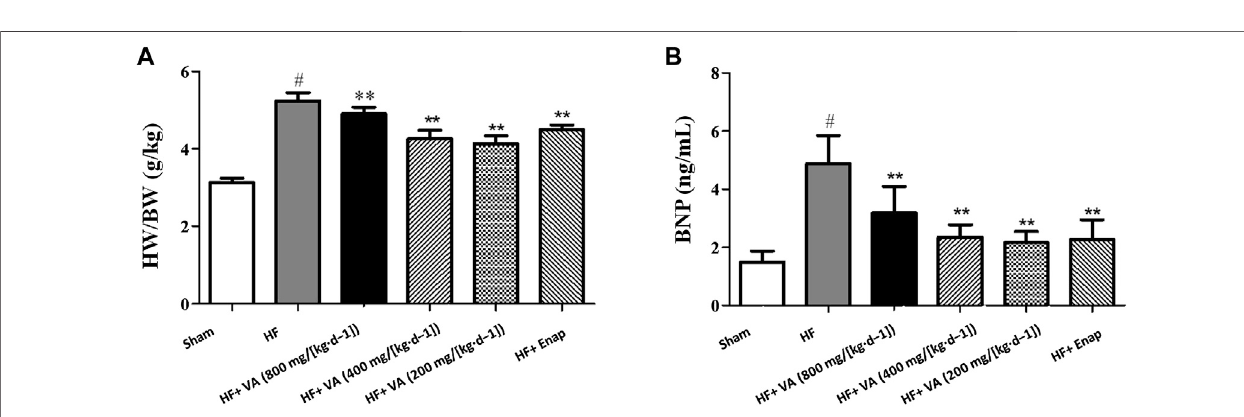
Frontiers in Pharmacology |